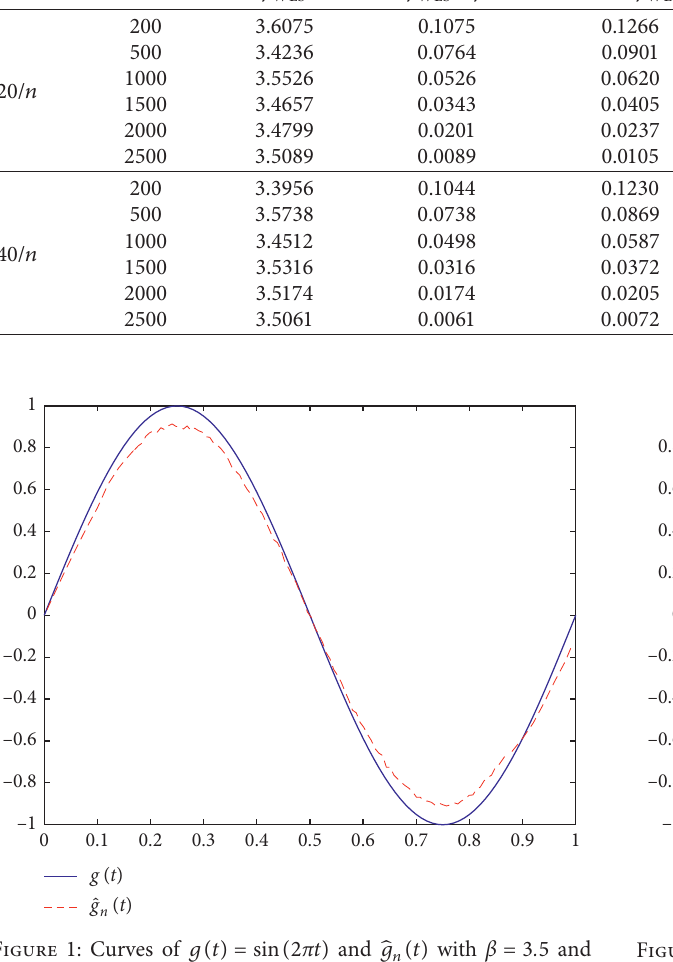
( t ) with β � 3 . 5 and n